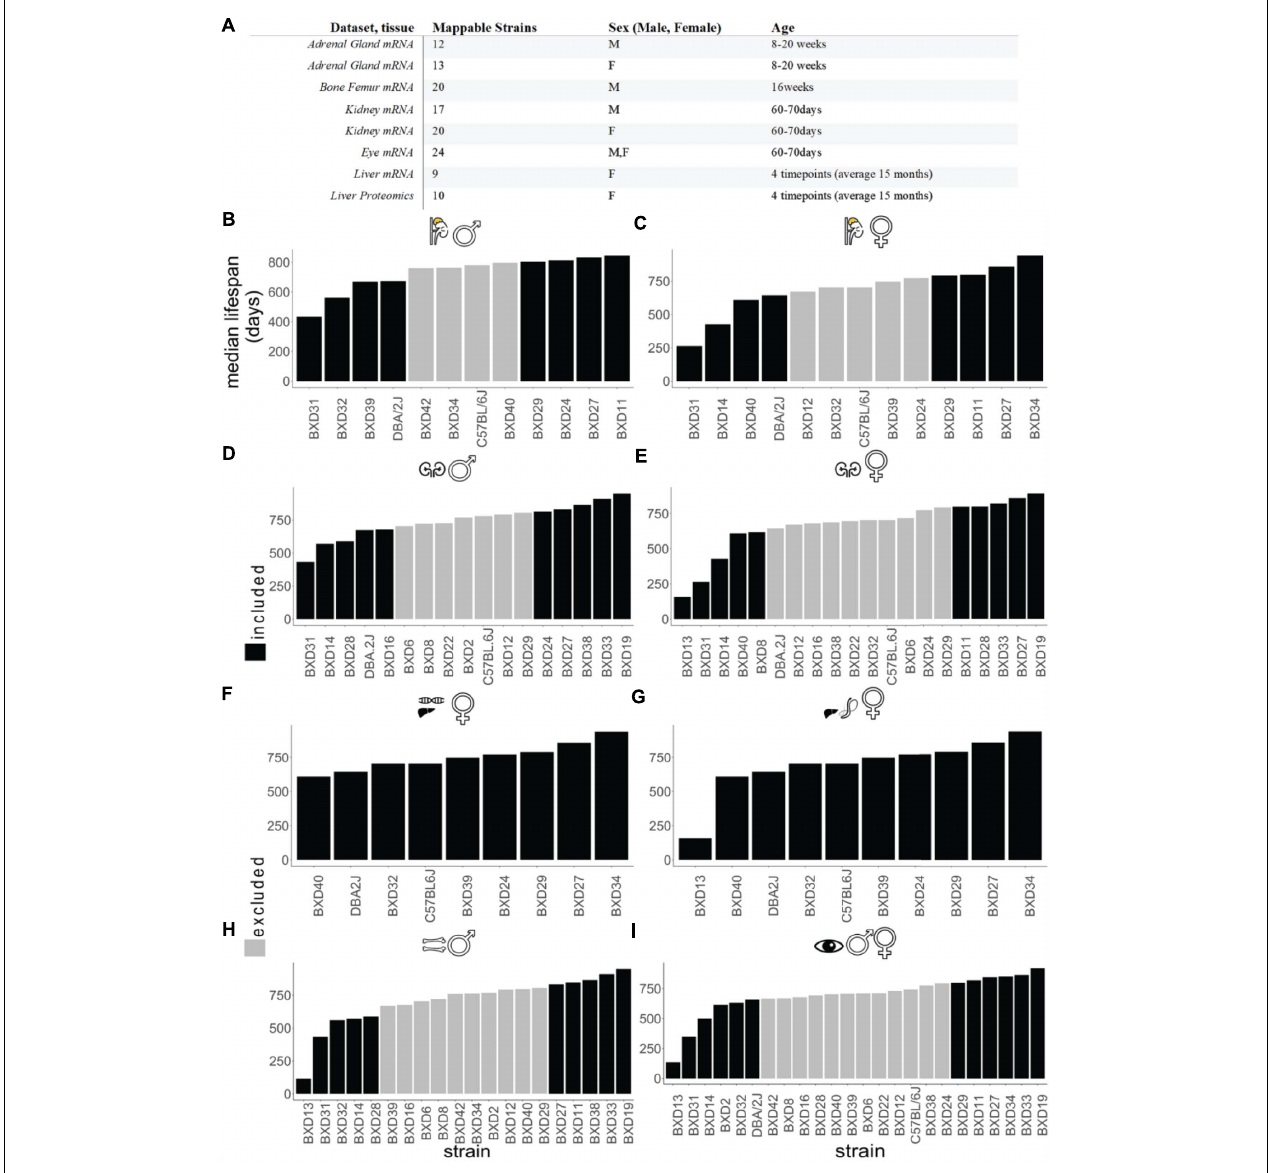
FIGURE 1 | Data landscape of BXD mice strains and lifespan. (A) The selection of datasets for the in silico analysis. All of the sets listed are downloaded from gene network 2 or GEO databases (http://gn2.genenetwork.org/ either directly or by the reference GEO accession). The strain’s total amount refers to the subset of the study strains which could be mapped to median strain lifespan values. See Supplementary Tables 1 , 2 for details. (B–I) Ordered strain median lifespans for each tissue. Adrenal gland male (B) female (C) , kidney male (D) , female (E) , liver female for transcriptomics (F) , liver female for proteomics (G) , bone femur male (H) , and sex-combined eye tissue (I) . The analyses encompass the subset of BXD strains which, within each dataset, were mappable to the employed experiment for BXD lifespans. In black are the top four shortest and longest-lived BXD mice